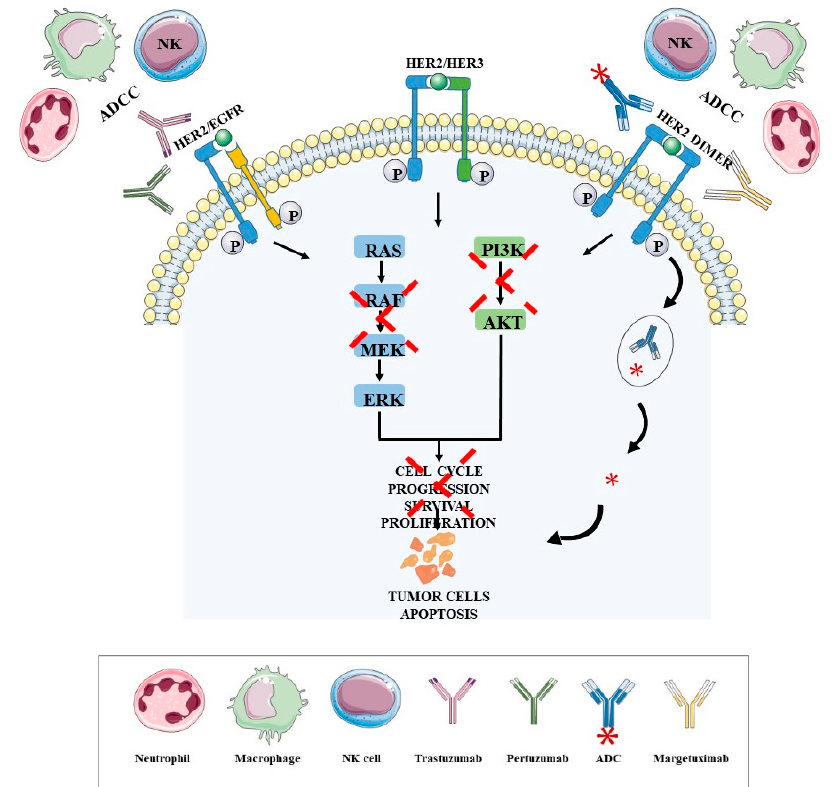
Figure 1. Immunotherapy modalities approved as a treatment for patients with HER2 BC and their mechanisms of action. Trastuzumab, Pertuzumab and Margetuximab are the mAbs approved for HER2 BC therapy directed for HER2 protein in tumor cells, specifically for the domain II (Pertuzumab) and domain IV (Trastuzumab). When the mAbs attach, the HER2 protein blocks the dimerization of HER2 protein with the other receptors (HER2, HER3 or EGFR), inhibiting the activation of the HER2 protein and consequently the activation of the PI3K and MAPK pathways, which leads to an increase in cell cycle arrest, the suppression of cell growth and proliferation, causing the apoptosis of tumor cells. These mAbs can also activate both innate and adaptive immune systems, inducing the ADCC that allows to kill HER2-overexpressing cells via NK cells, macrophages and neutrophils, and eliciting an adaptive immune response based on HER2 presentation by MHC-I molecules to activate the anti-tumor activity of CTL. Other immunotherapies approved are the Trastuzumab-Emtansine and Trastuzumab Deruxtecan, that are an ADC who consists in a therapy that conjugates the Trastuzimab covalently conjugated with the cytotoxins DM1 (Trastuzumab-Emtansine), a microtubule polymerization inhibitor, and topoisomerase I inhibitor payload (Dxd) (Trastuzumab Deruxtecan), responsible for the inhibition of DNA replication. The Trastuzumab directs the ADC to the tumor cells that express HER2 protein and when the Trastuzumab binds to the HER2 protein the ADC goes into the cell by receptor-mediated endocytosis and the lysosomes degrade the Trastuzumab, realizing the DM1 or the Dxd. The DM1 inhibits the microtubule function and the Dxd inhibits the topoisomerase I, causing the cell cycle arrest and tumor cell apoptosis. Abbreviations are as follows: Antibody Dependent Cytotoxic Cell (ADCC), Antibody Drug Conjugate (ADC), Natural Killer (NK), Human Epidermal growth Receptor 2 (HER2), Human Epidermal Growth Receptor 3 (HER3), Human Epidermal Growth Factor Receptor (EGFR), Phosphatidylinositol-3-kinase (PI3K), Extracellular regulated kinases (ERK), Mitogen-activated protein kinase kinase (MEK), Protein kinase B (AKT).